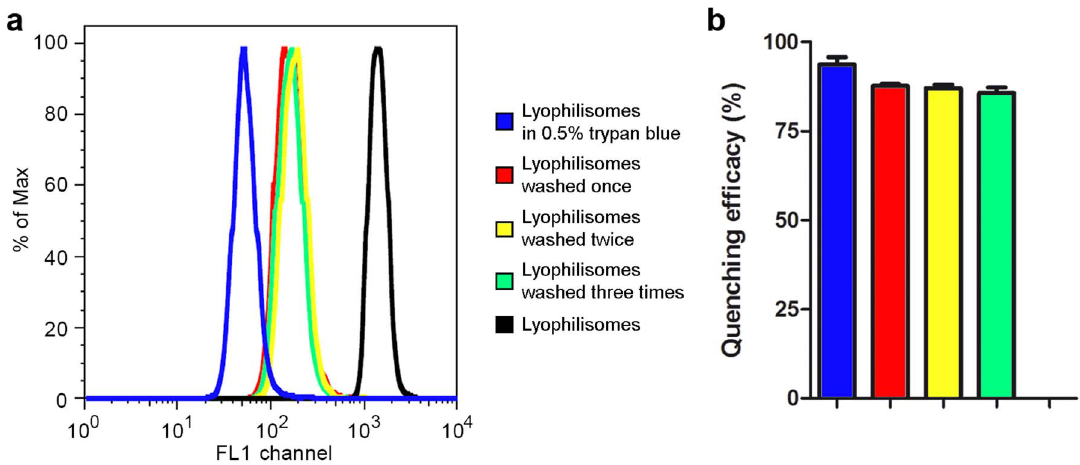
Figure 4. Quenching of FITC fluorescent lyophilisomes by trypan blue in the absence of cells. Results show decreased fluorescence (a) and efficient quenching (b) up to three washings steps of FITC fluorescent lyophilisomes by trypan blue.